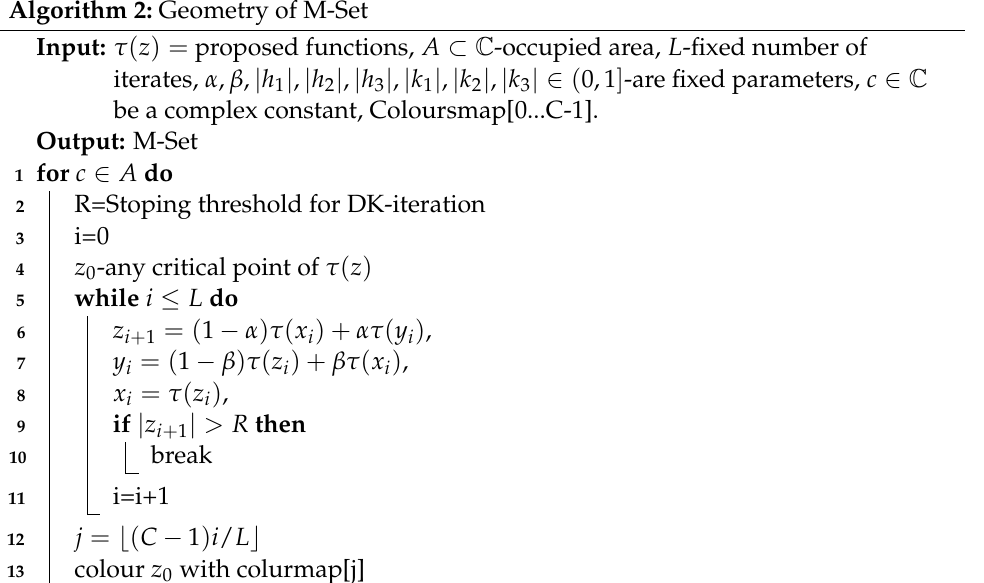
Algorithm 2: Geometry of